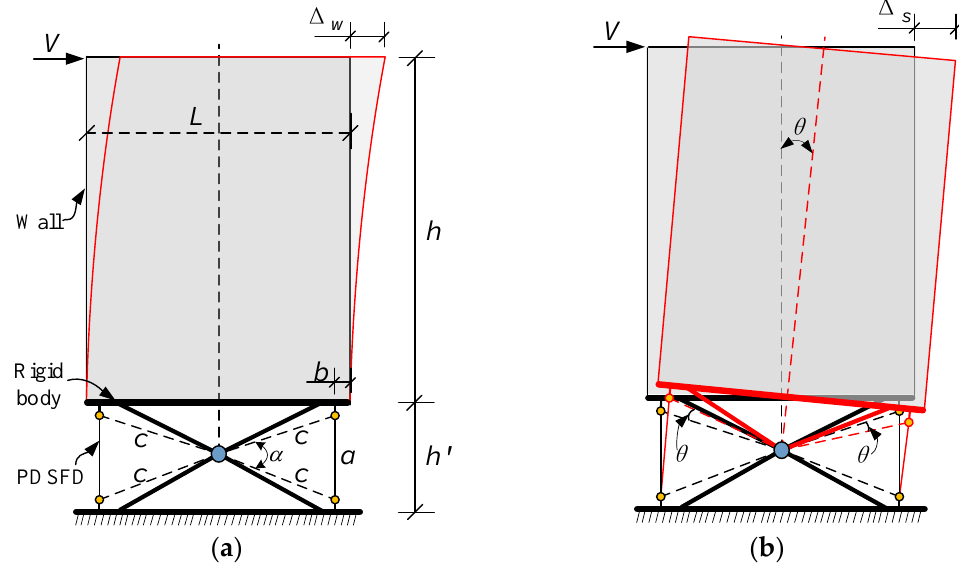
Figure 5. Deformation mode of PSCRSW. ( a ) Bending shear deformation of the wall. ( b ) Rocking deformation.